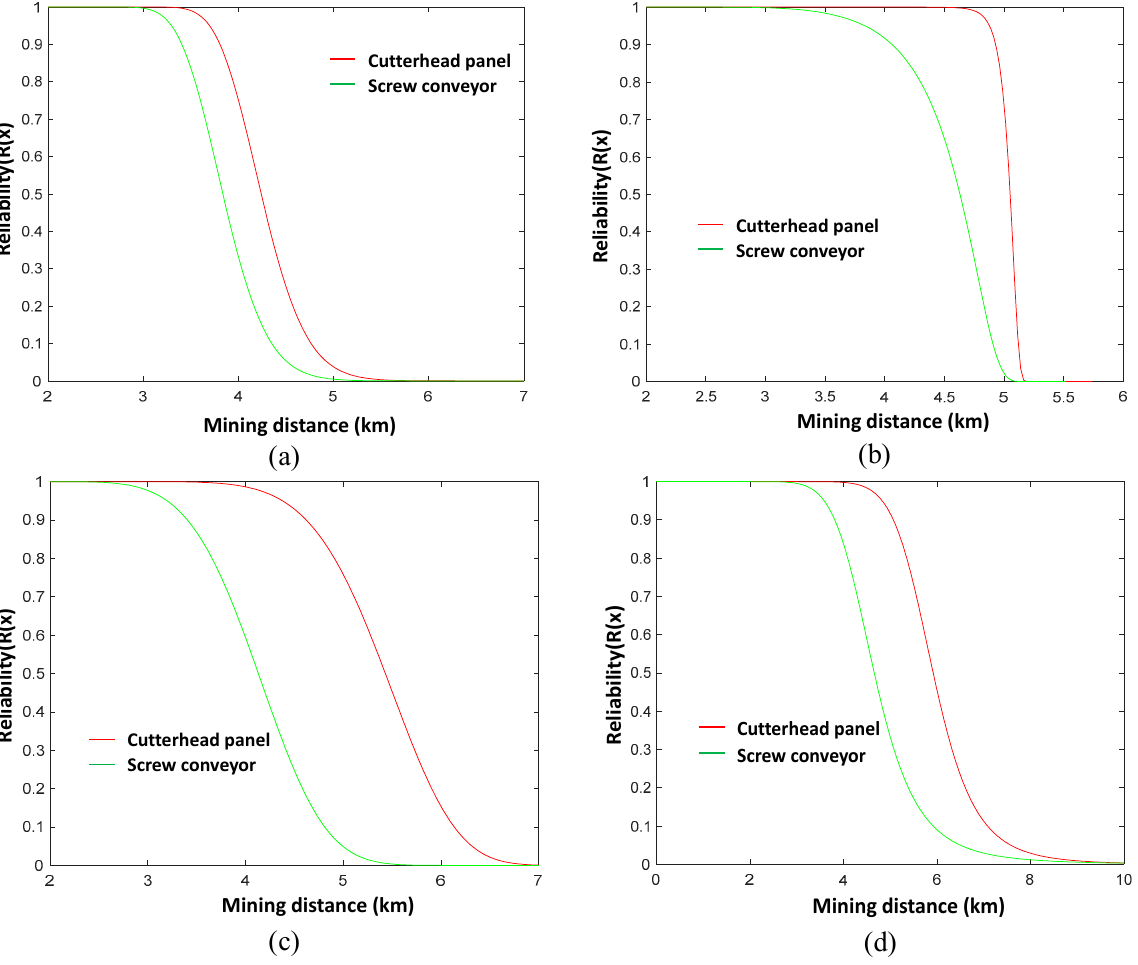
Figure 6. Marginal reliability function for the cutter head and screw conveyor under ( a ) normal distribution; ( b ) Weibull distribution; ( c ) Gumbel distribution; and ( d ) logistics distribution.